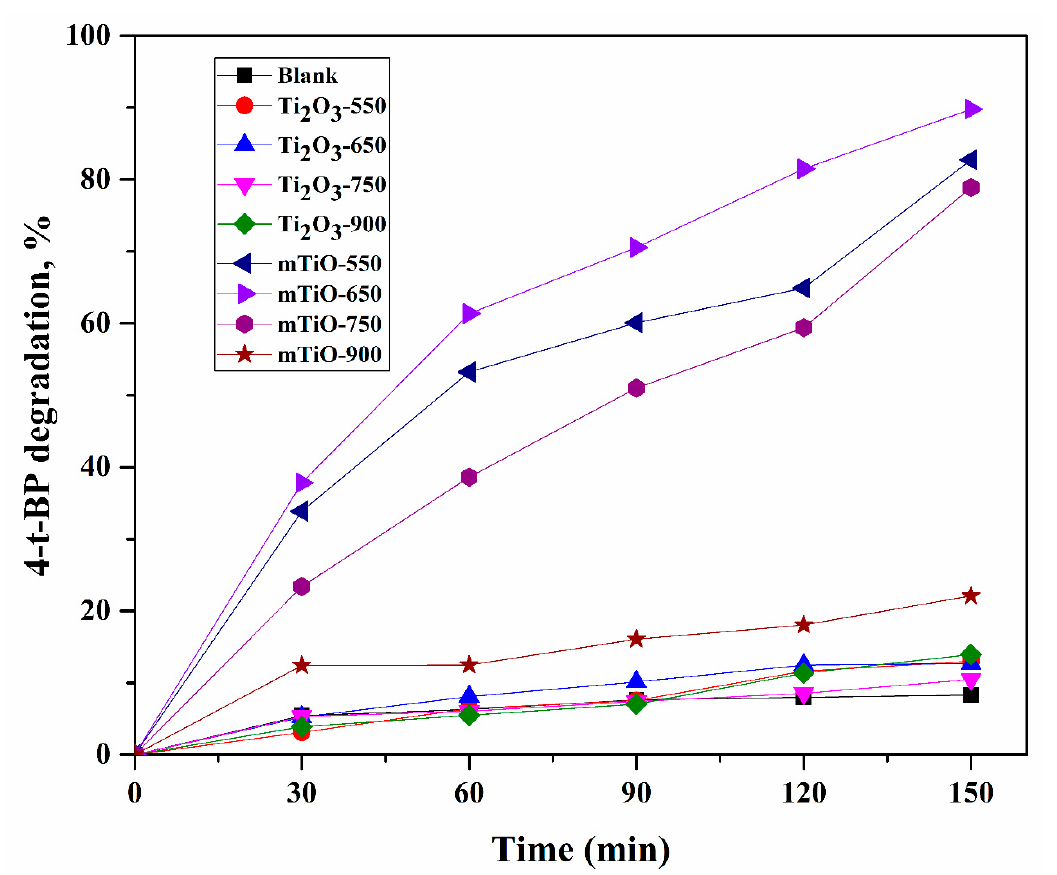
Figure 14. The 4-t-BP degradation under solar light irradiation in the presence of prepared catalysts. Reaction conditions: [4-t-BP] 0 = 5 mg/L, [photocatalyst] = 200 mg/L.